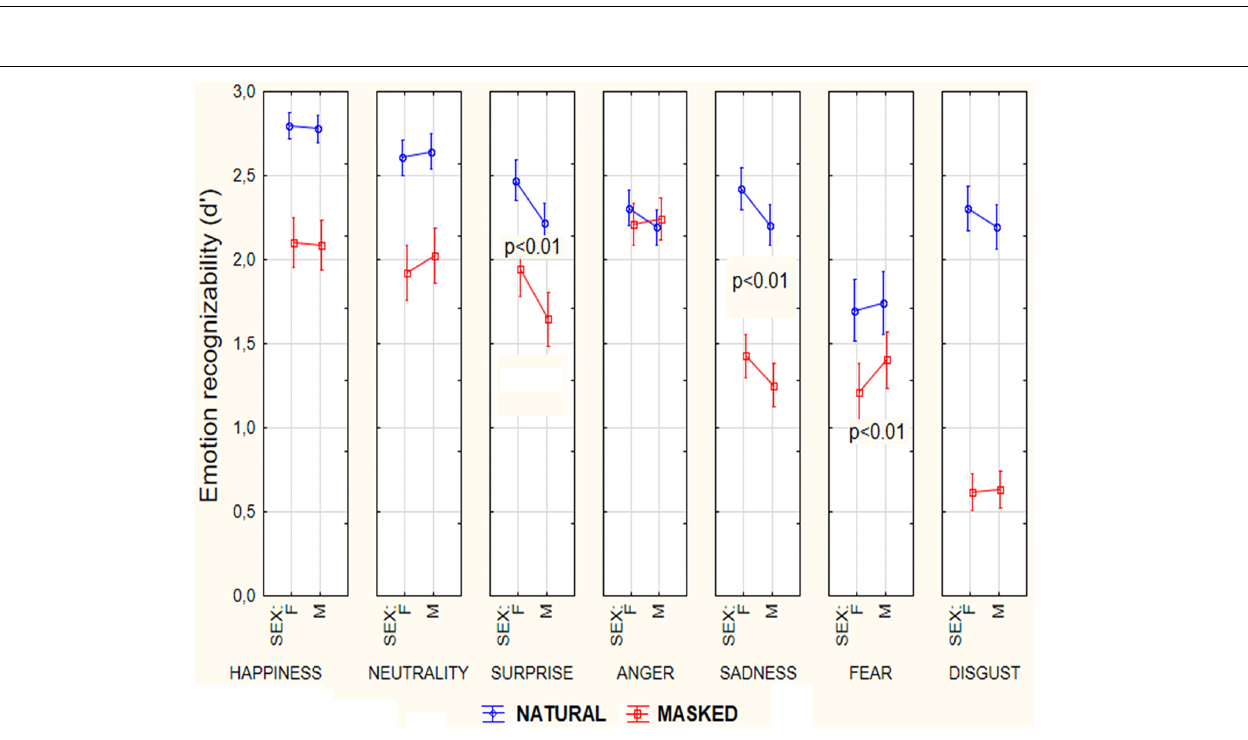
FIGURE 5 | Mean scores (along with SE values) of recognizability attributed by participants ( N = 94) to the various facial expressions as a function of sex of viewers and masking condition. Scale ranged from 0 = “not much recognizable” to 3 = “very well recognizable”.